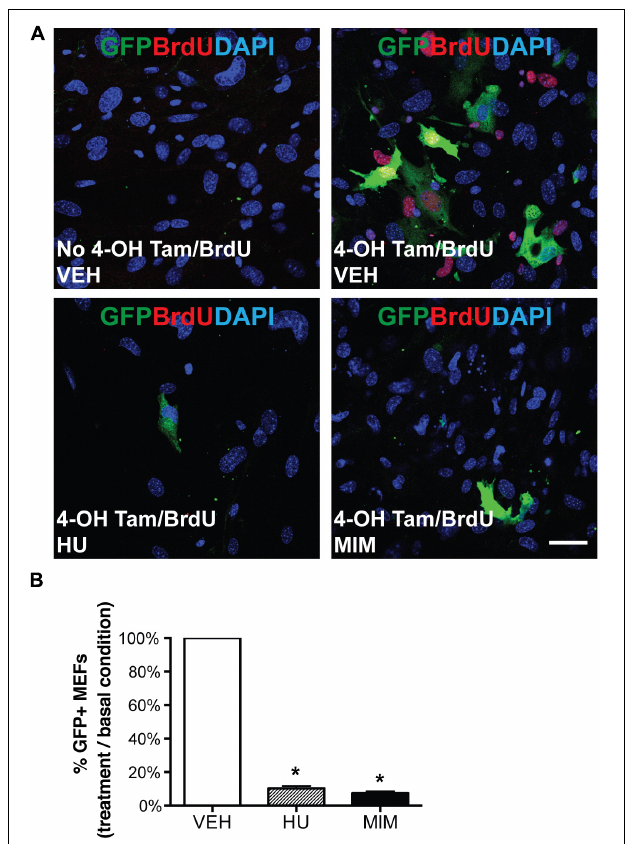
FIGURE 4 | Aurkb ER Cre / + labeling of MEFs. Aurkb ER Cre / + ; R26R eYFP / + MEFs were cultured in 10% FBS standard medium. MEFs were treated with cell cycle blockers for a total of 48 h. 24 h after the treatment, BrdU (10 µ M) and 4-OH tamoxifen (1 µ M) were added in the medium and maintained for 24 h before cell harvest. YFP immunosignal was detected by GFP antibody. (A) Representative micrographs of BrdU and GFP immunofluorescence staining of Aurkb ER Cre / + ; R26R eYFP / + MEFs under various culture conditions. Scale bar, 50 µ m; (B) The Aurkb ER Cre / + labeling percentage was quantified by flow cytometric analysis. The percentage was calculated as the number of GFP + cells under each treatment condition as divided by the number of GFP + cells in the control condition. VEH, vehicle control; HU, hydroxyurea (2 mM); MIM, mimosine (1 mM). n = 3 for each condition, * P < 0.05 when compared to the control group by ANOVA followed by Bonferroni post hoc